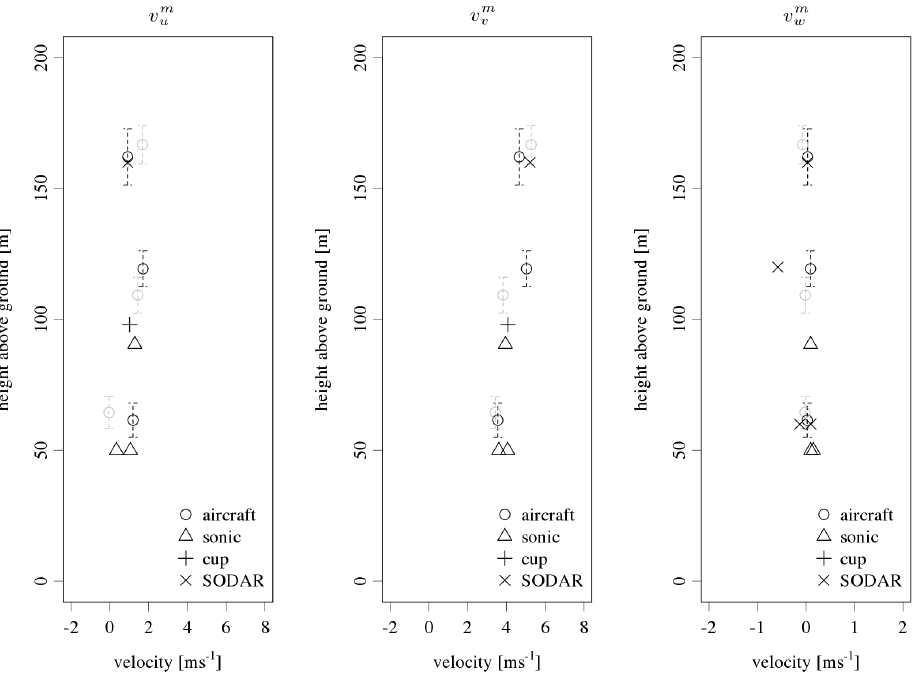
Fig. 12. Vertical profiles for horizontal ( v m uv ) and vertical ( v m w ) wind components of simultaneous ground based and weight-shift microlight aircraft measurements on 15 October 2008, 14:50–16:00CET. Different symbols indicate the different wind sensors. Black circles represent aircraft measurements at 24ms − 1 true airspeed, while grey circles represent measurements at 27ms − 1 true airspeed. Vertical error bars indicate one standard deviation of the aircraft altitude.